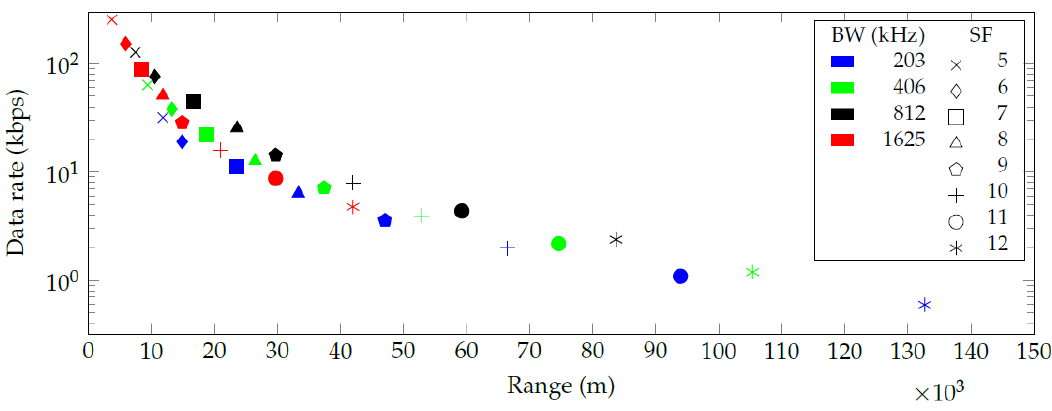
Figure 2. Communication range and data rate for every combination of spreading factor (SF) and bandwidth (BW) in a free space line of sight (LoS) environment.